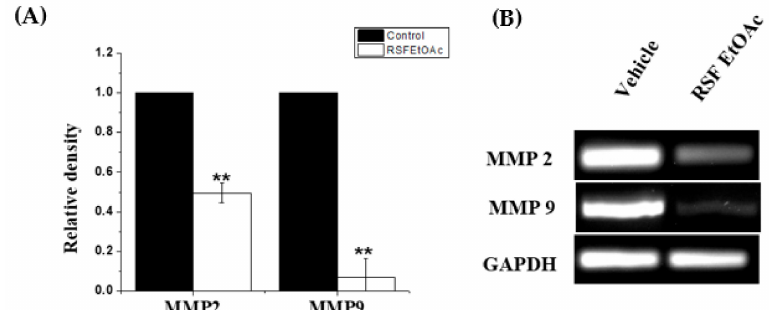
Figure 6. E ff ect of RSF EtOAc extract on expression of MMP-2 and MMP9 in MDA-MB-231 breast cancer cells. ( A ) The relative density variation of mRNA levels found in MDA-MB-231 treated at IC 50 when compared with control. ( B ) Ethidium bromide–agarose gel showing MMP2 and MMP9 mRNA levels: Lane 1) Vehicle control, Lane 2) extract treated. Results are expressed as mean ± SD ( n = 3). Statistical significance was assessed by Student’s t -test. Relative mRNA level was normalized to GAPDH mRNA level. * p < 0.05; ** p < 0.01; treatment group vs. control.